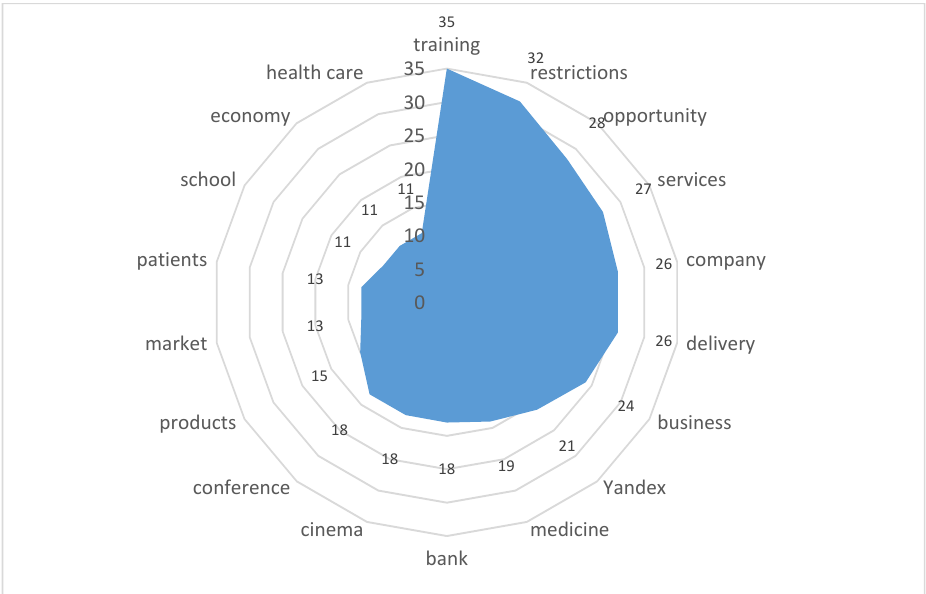
Figure 13. Associative network for stimulus online-services